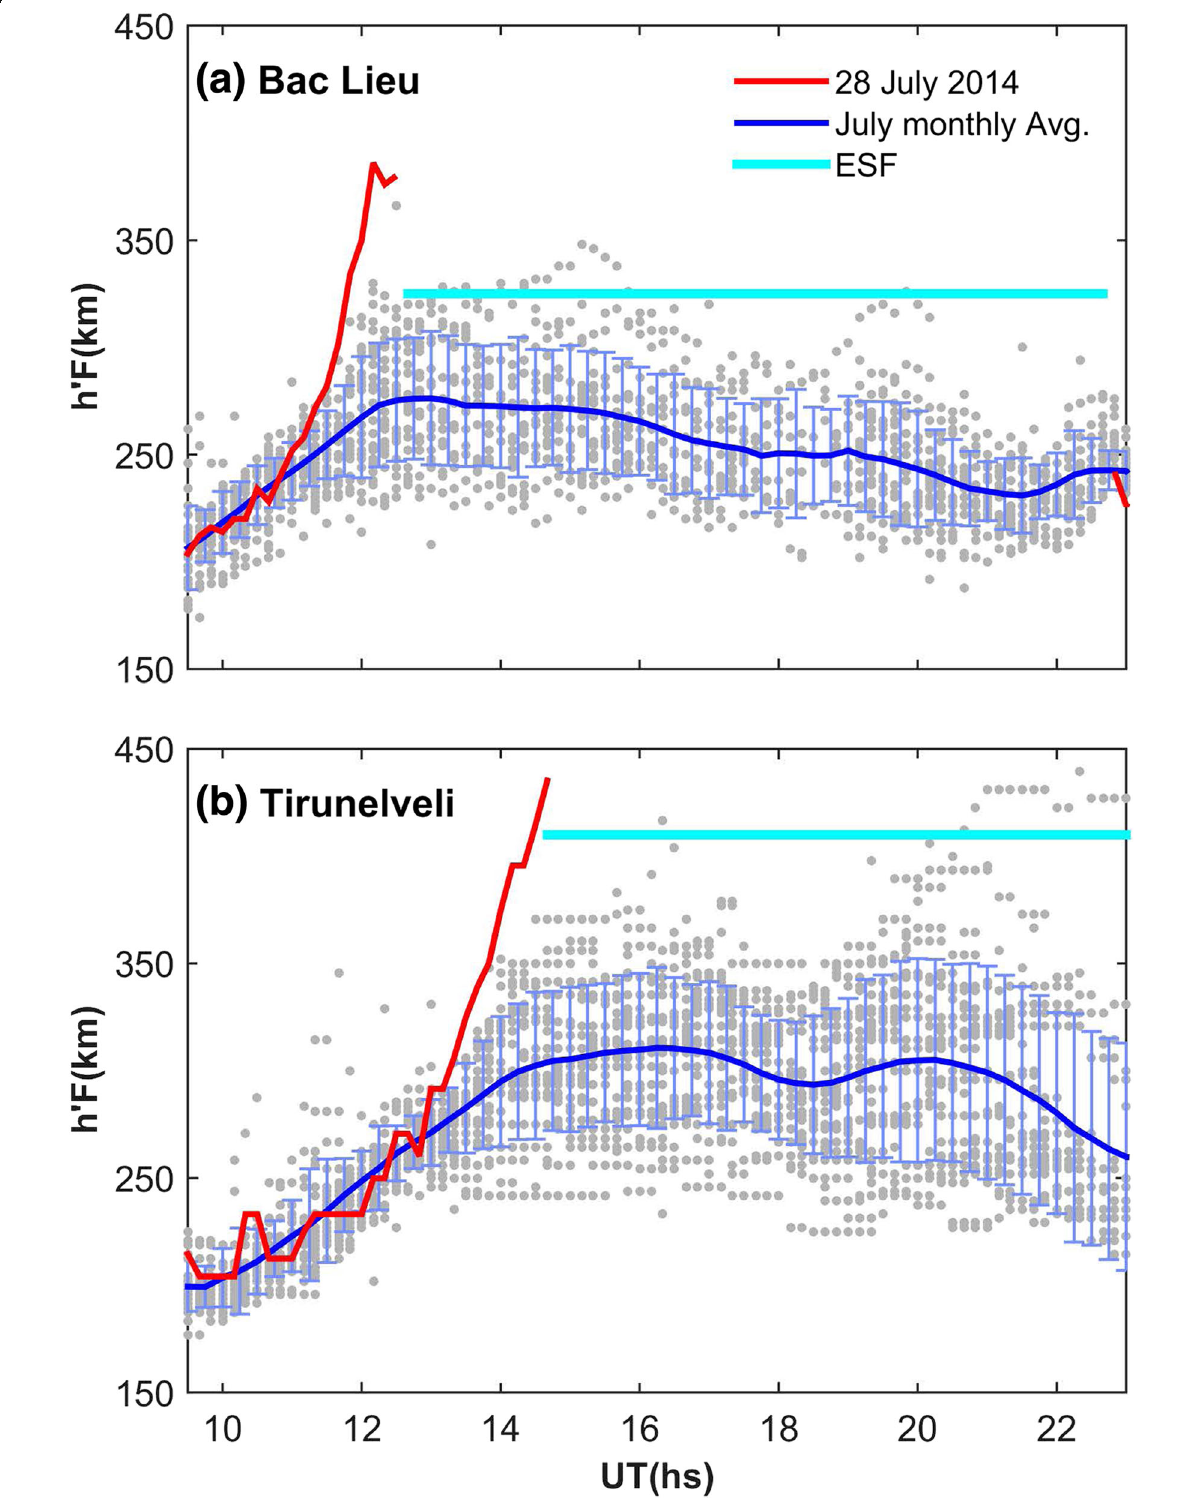
Fig. 5 The F-layer base (virtual) height (h ′ F) variations over a Bac Lieu and b Tirunelveli on 28 July 2014 (red line) along with the corresponding monthly mean (blue lines with error bars). Cyan line indicates the duration of Equatorial Spread F